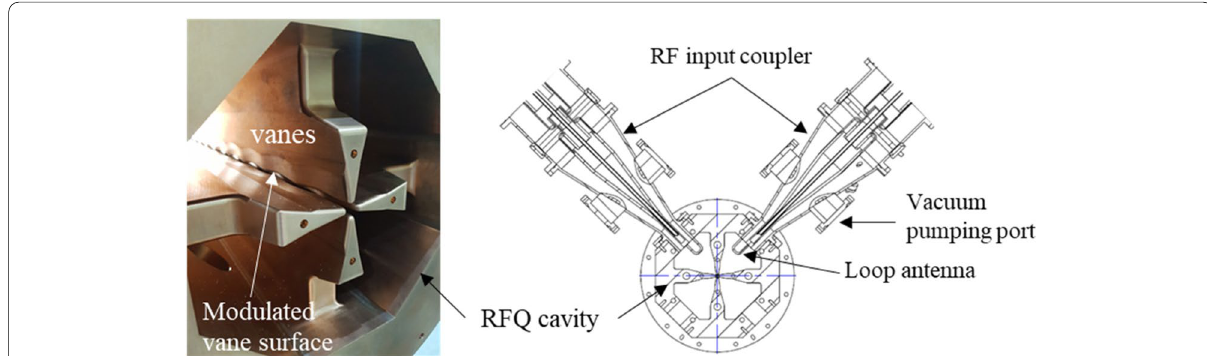
Fig. 10 (Left) Photo of 4‑vane RFQ and (right) cross‑sectional view of RFQ and RF input